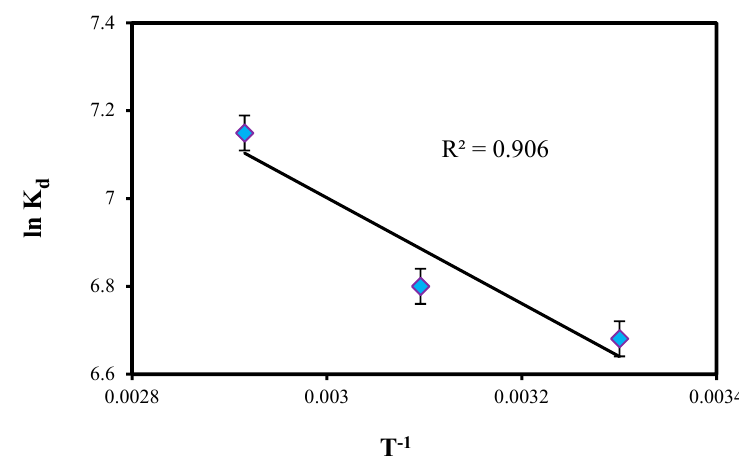
Figure 8. Plot of lnK d vs. T − 1 for the adsorption of Pb(II) onto ZnO-Nano-A.